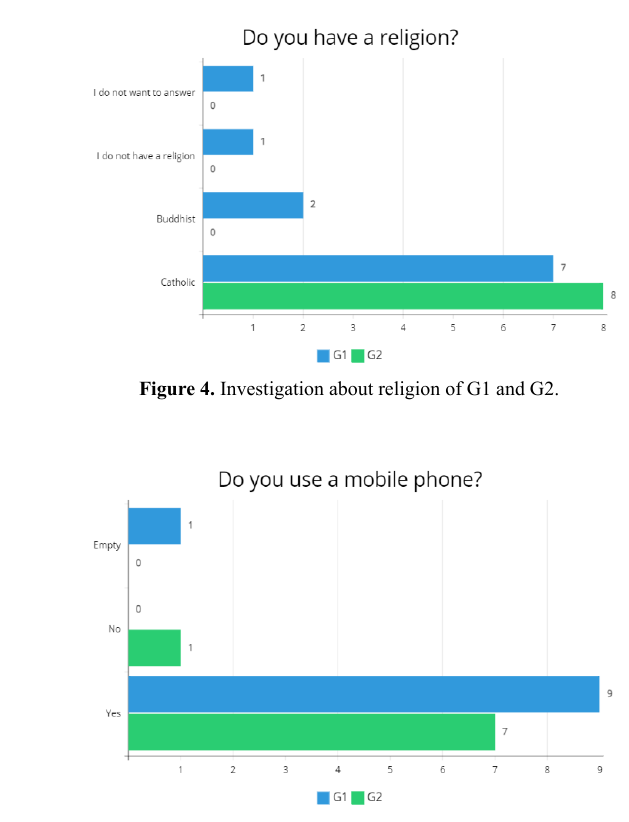
Figure 5. Use of mobile phones G1 and